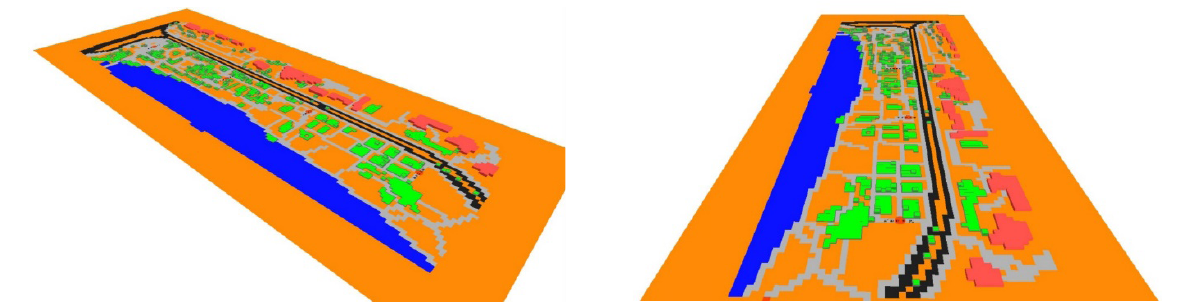
Figure 4. Initial models of the east side of the river